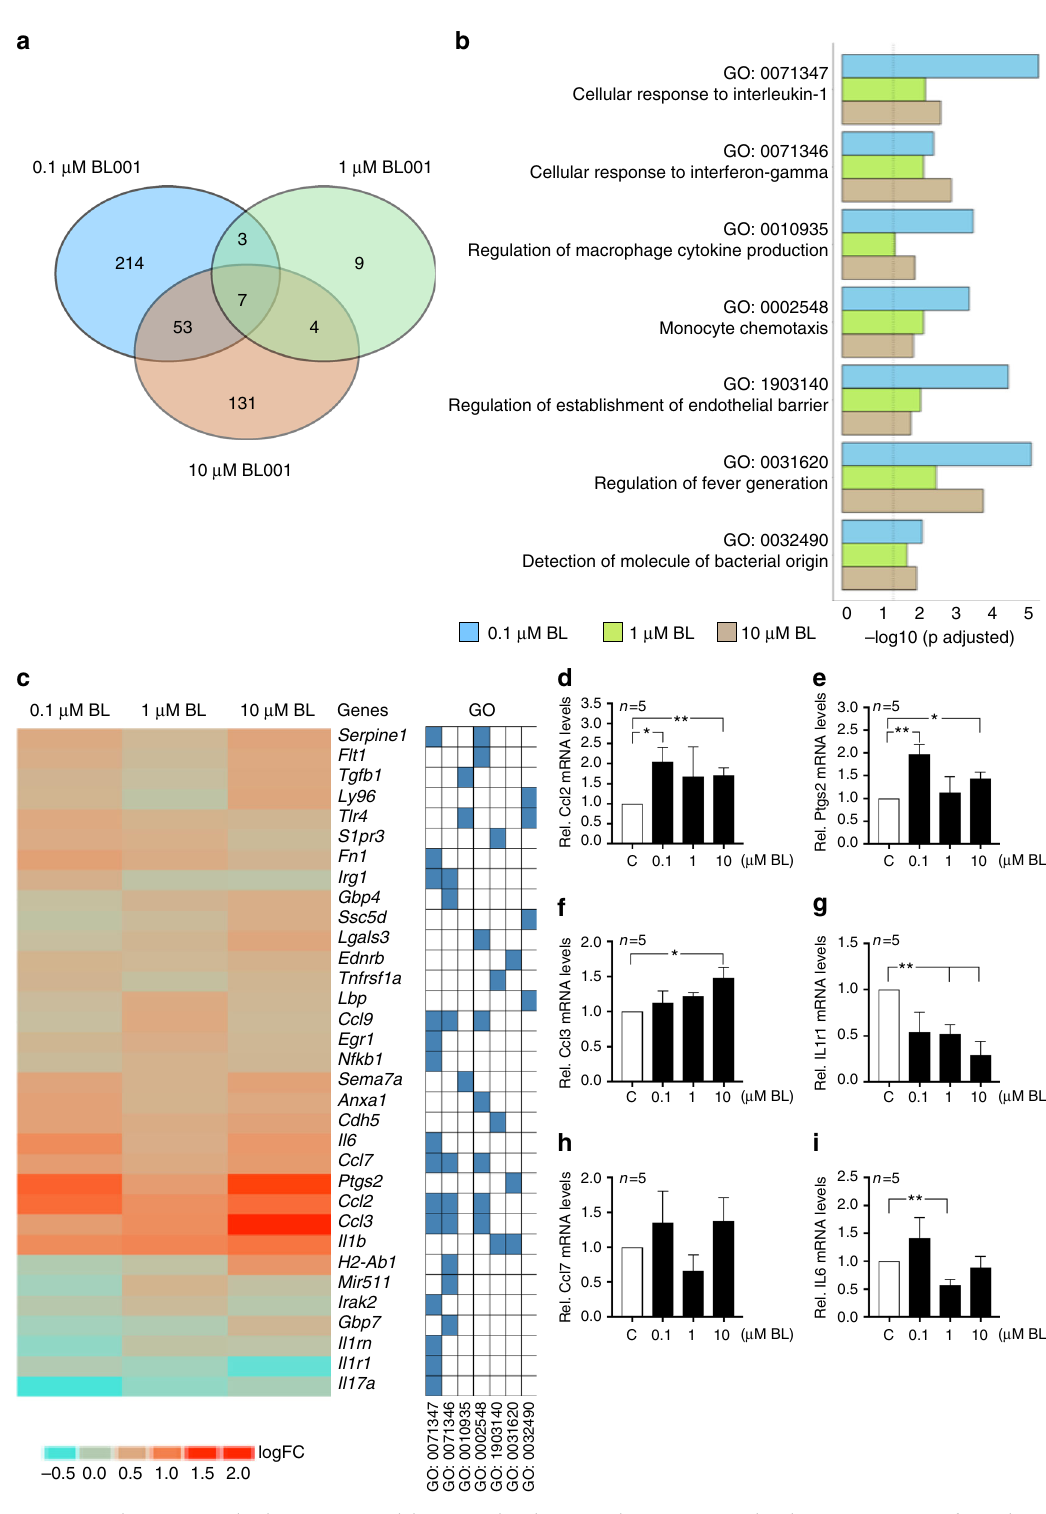
Fig. 7 BL001 potentiates islet genes involved in immunomodulation. Isolated mouse islets were treated with 0.1 – 10 μ M BL001 for 24 h and RNA isolated for DNA microarray analysis ( n = 3 independent islet preparations per BL001 concentrations). a Venn diagram depicting the number of GO terms signi fi cantly enriched after three different BL001 treatment. b Enrichment plot for the seven GO terms common to all three BL001 concentrations. c Heatmaps displaying logFC values of transcripts modulated by BL001, and their association with common GO processes. Blue cells re fl ect the membership of a gene to a given GO BP term. Validation by QT-PCR of d Ccl2, e Ptgs2, f Ccl3, g Il1r1, h Ccl7, and i Il6 transcript levels in mouse islets treated with BL001. n = 5 independent islet preparations. * p < 0.05 and ** p < 0.01, Student ’ s t test versus control untreated